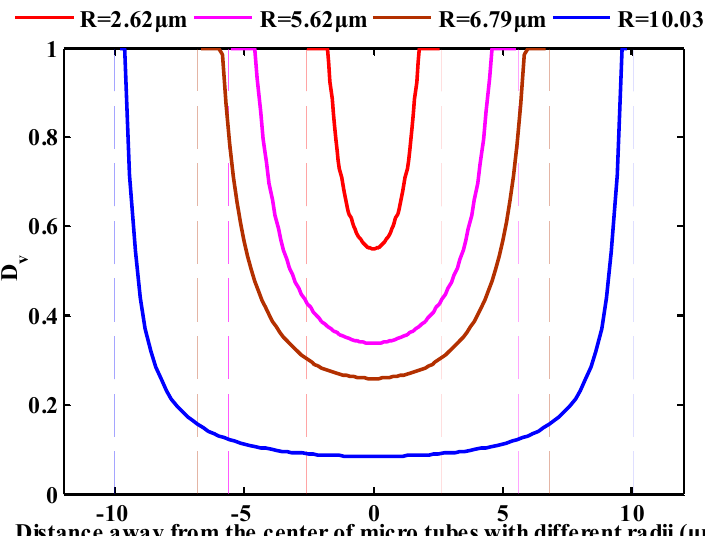
Figure 11. Deviations of velocity profile in different radial micro tubes.